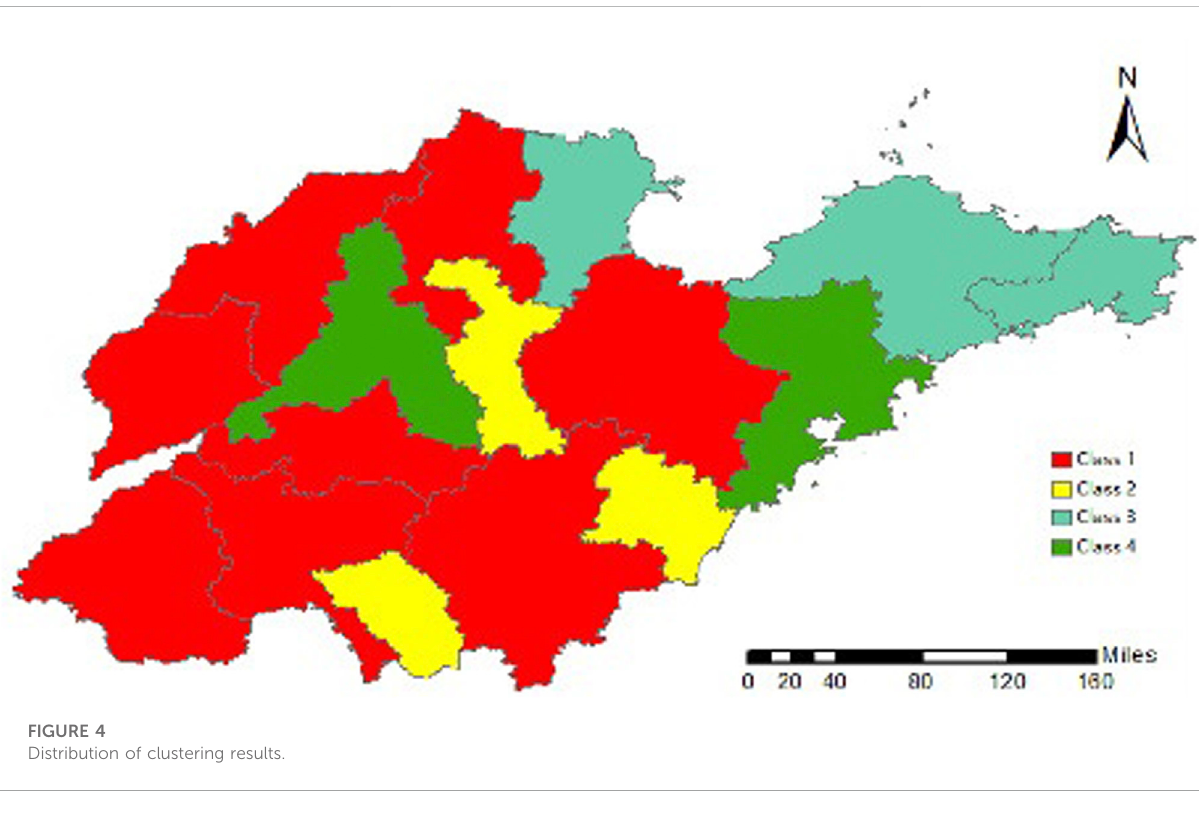
FIGURE 4 Distribution of clustering results.